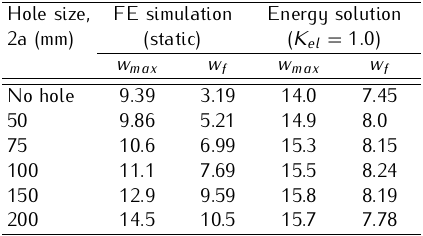
Table 1. Maximum, w max , and final, w f , displacements (mm) for 0.5 m square plate, 1 mm thick with square hole loaded statically to 1